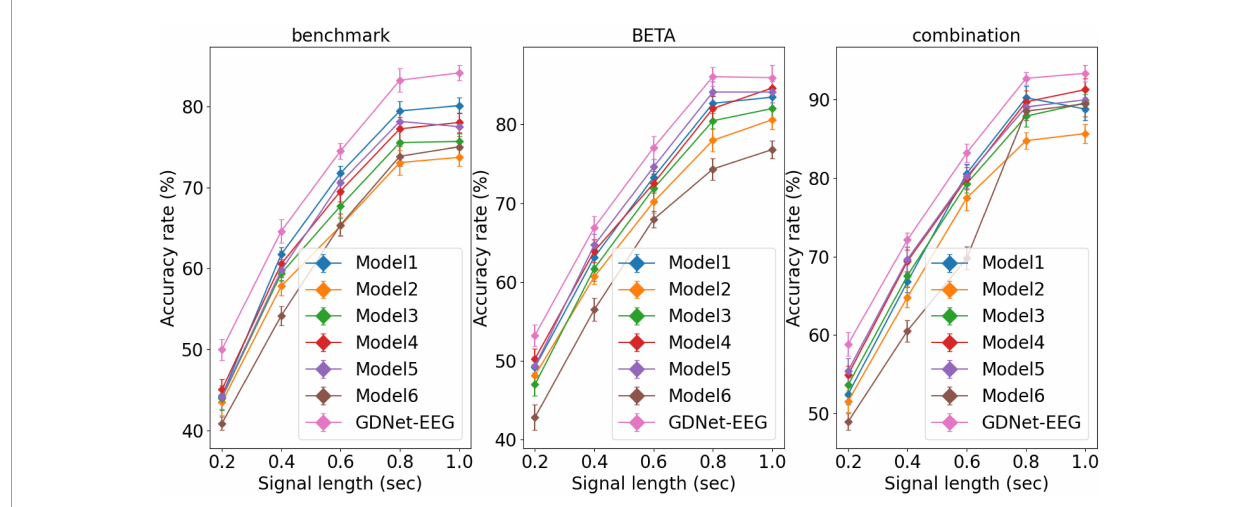
FIGURE4 Average classification accuracies obtained by GDNet-EEG and model 1 ∼ model 6 over 10-fold cross-validation. Error bars indicate standard errors.